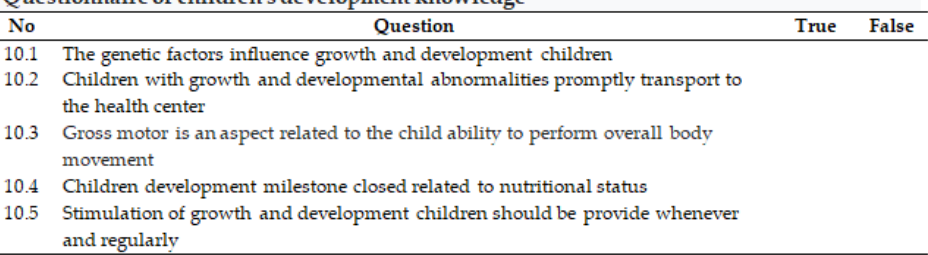
Figure 3. Screenshot of the web-based questionnaire.